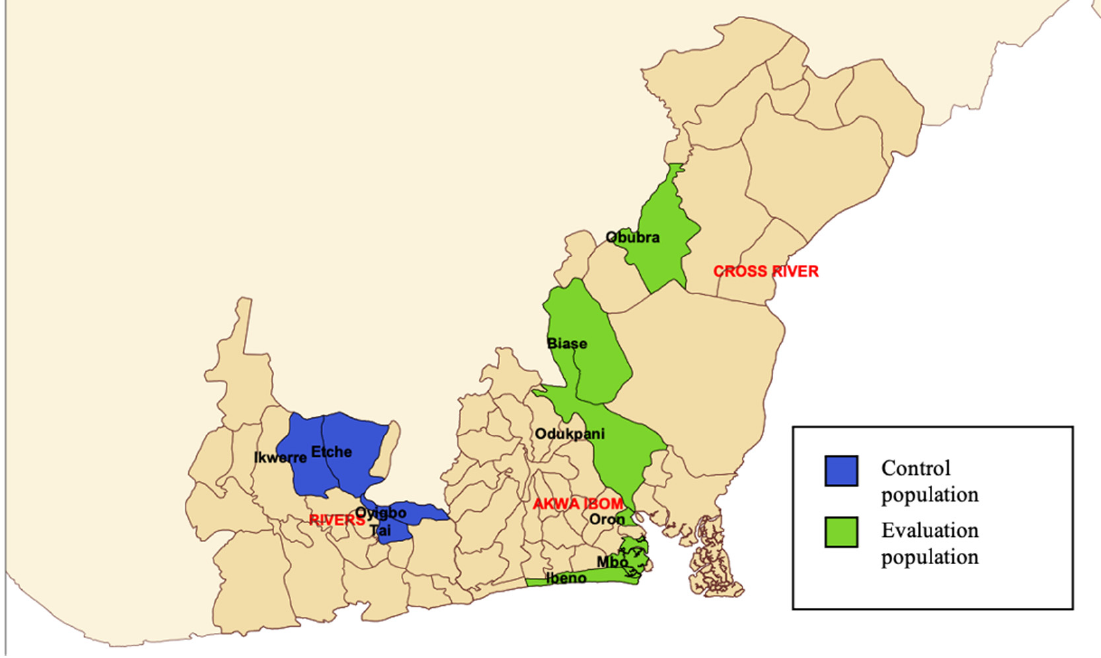
Figure 1. Map of selected LGAs in the control (Rivers State) and evaluation populations (Akwa Ibom and Cross River States) for the ECEWS intervention.